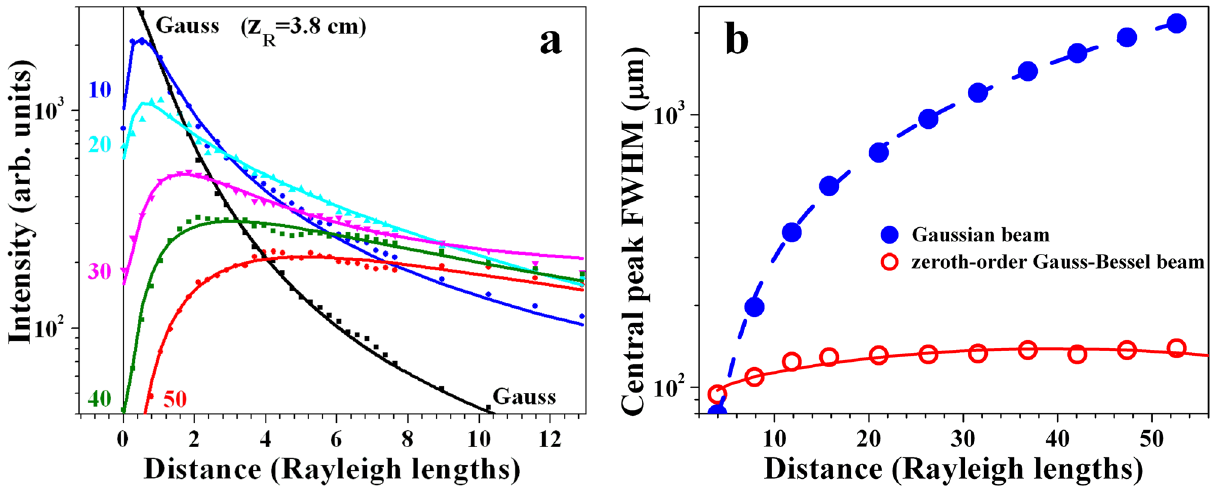
Figure 5. Graph (a) —intensity of the Gaussian beam vs. propagation distance behind the focus of the lens (black curve) in units of Rayleigh diffraction length ( z R =3.8 cm). For comparison, the variation of the central peak intensity of the Gauss-Bessel beams vs. distance (in units of z R ) are shown for | TC |=10, 20, 30, 40, and 50 corresponding to r 0 /ω 0 = 8.7, 14.8, 21.2, 29.2, and 31.6 (color lines). Graph (b) —measured width (FWHM) of a Gaussian beam (blue solid dots) and of the central peak of the Gauss–Bessel beam (red hollow circles) vs. free space propagation distance (in units of z R , in the particular measurement—from 15 to 200 cm behind the focus of the lens). The GBB is generated using OVs with topological charges | TC | = 30 on the SLMs ensuring r 0 /ω 0 =21.2 in the plane of the